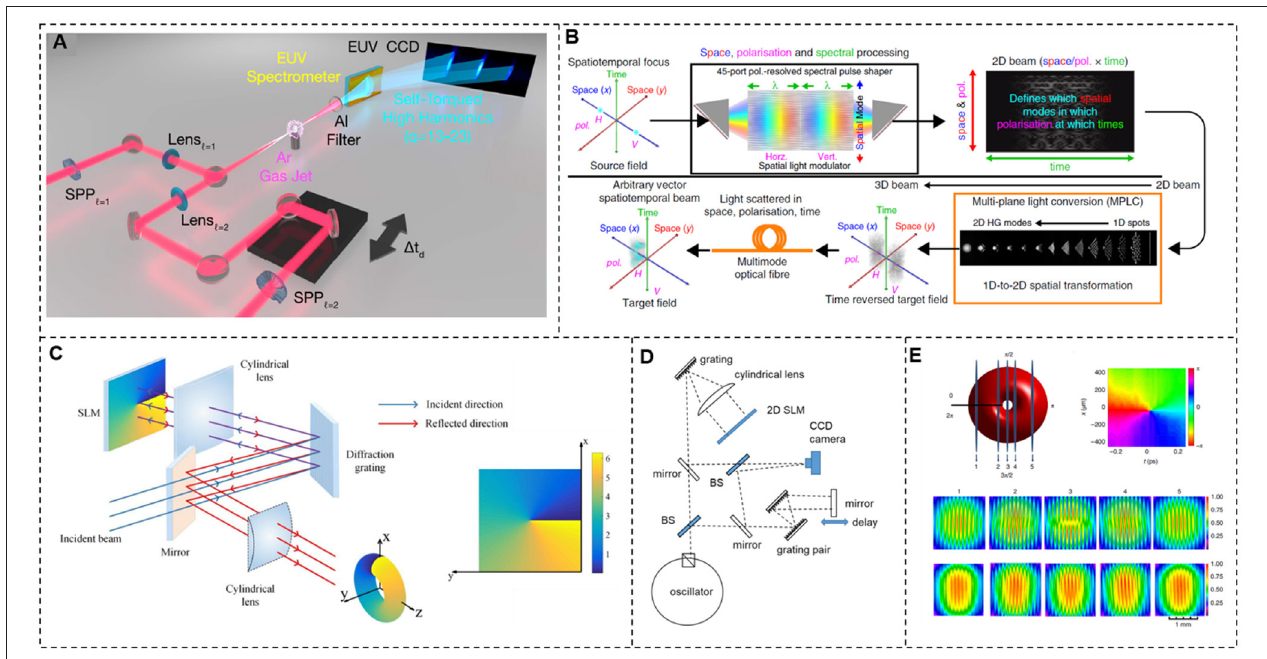
FIGURE 10 | Generation and detection of spatiotemporal light beams. (A) Schematic of generating extreme-ultraviolet beams with time-varying orbital angular momentum. Reprinted from Rego et al. [14]. (B) Schematic of generating vector spatiotemporal light fields with arbitrary amplitude, phase, and polarization at every point in space and time. Reprinted from Mounaix et al. [ 100]. (C) An experimental setup for the generation of a spatiotemporal optical vortex beam with transverse orbital angular momentum. Reprinted from Chong et al. [13]. (D,E) Detection of spatiotemporal optical vortex beams. Reprinted from Chong et al.